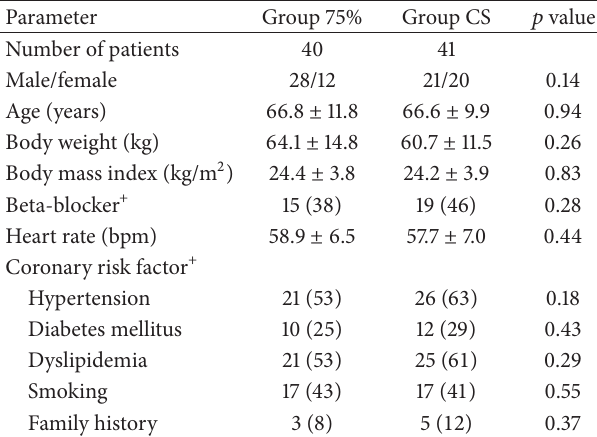
Table 1: Patient demographics.